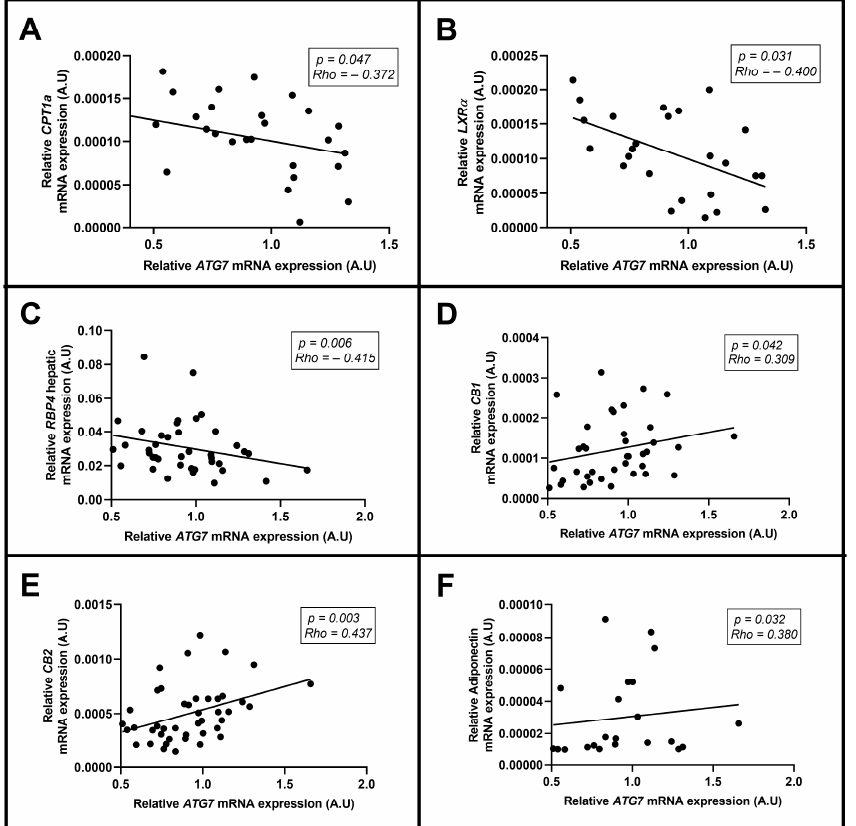
Figure 5. Significant correlations between ATG7 mRNA hepatic expression and ( A ) CPT1a , ( B ) LXR α , ( C ) RBP4 , ( D ) CB1 , ( E ) CB2, and ( F ) adiponectin hepatic expression using Spearman’s